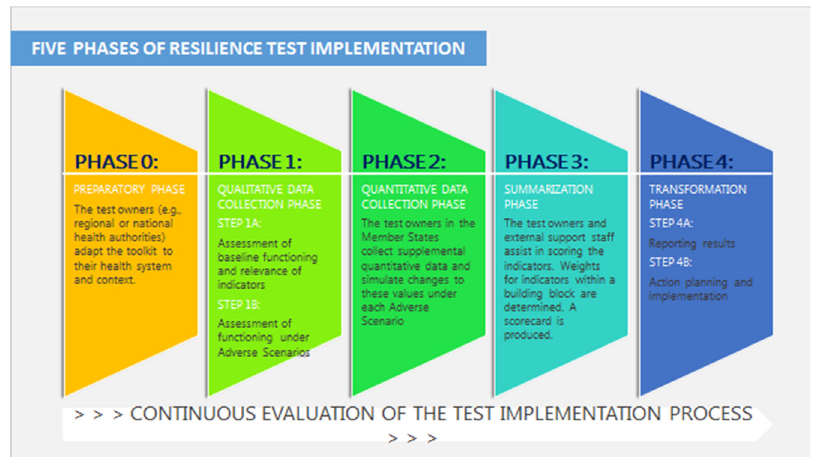
Figure 3. Five phases of resilience test implementation. Source: Modified from the Expert Panel Opinion